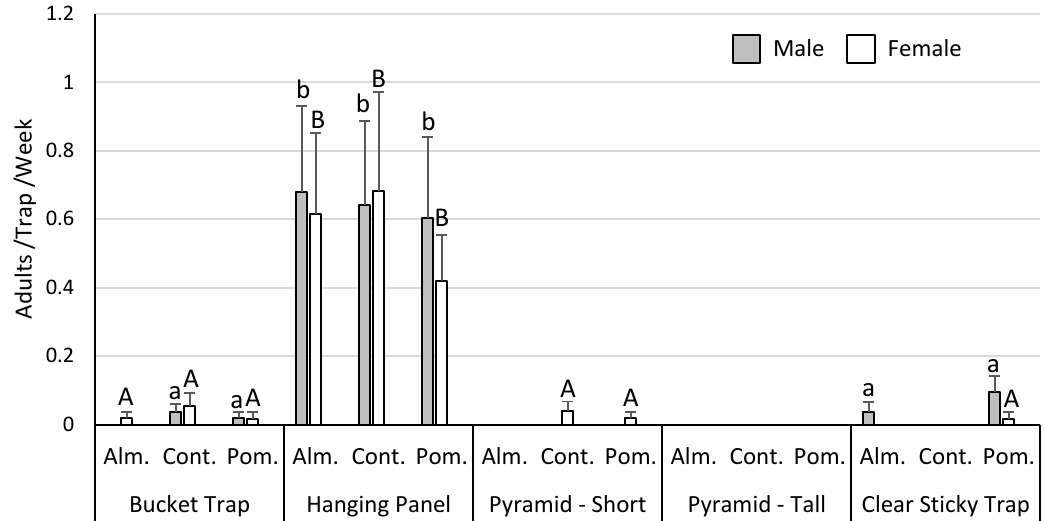
Figure 1. The hanging cross-vane panel trap consistently captured the most L. zonatus , regardless of bait type. Columns of the same color without a common letter differ significantly. Alm. = almond meal bait, Cont. = no bait control, and Pom. = pomegranate bait; Bucket Trap = green-white-yellow bucket trap, Hanging Panel = black hanging cross-vane panel trap, Pyramid - Short = 0.6 m pyramid trap, Pyramid - Tall = 1.2 m pyramid trap, and Clear Sticky Trap = clear sticky dual panel trap.